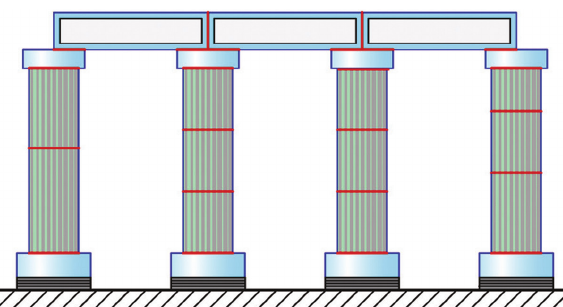
Figure 1: Typical section of a